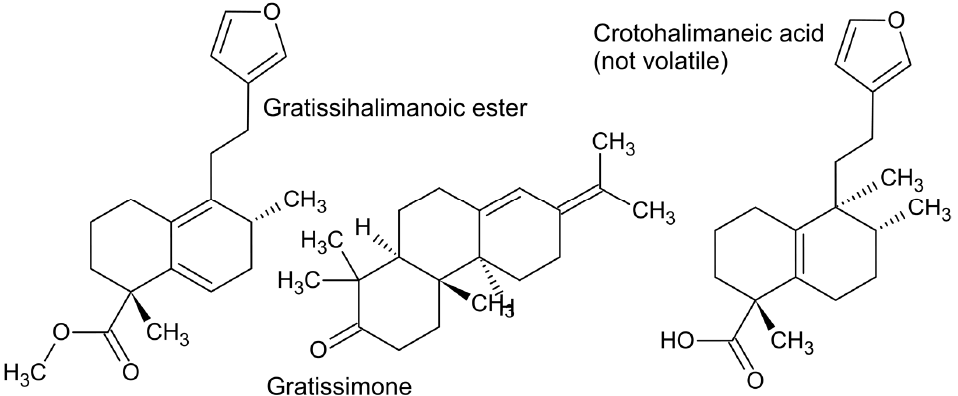
Figure 6. Two volatile diterpenes that comprise the major fraction of an essential oil from Croton gratissimus , sampled at the Pretoria Botanic Gardens, South Africa. Terpenes can also combine with phenylpropanoids or phloroglucinols to become ‘meroterpenes’, such as osthole, which is a prenyl coumarin that is often detected in essential oils [28]. Nevertheless, there are many examples of meroterpenes in the genera Peperomia [29] and Psoralea [30], such as bakuchiol (Figure 7) that are light enough and have polar head space that is low enough to enable collection by hydrodistillation, so it is just a matter of time before such essential oils will be reported in the published literature.